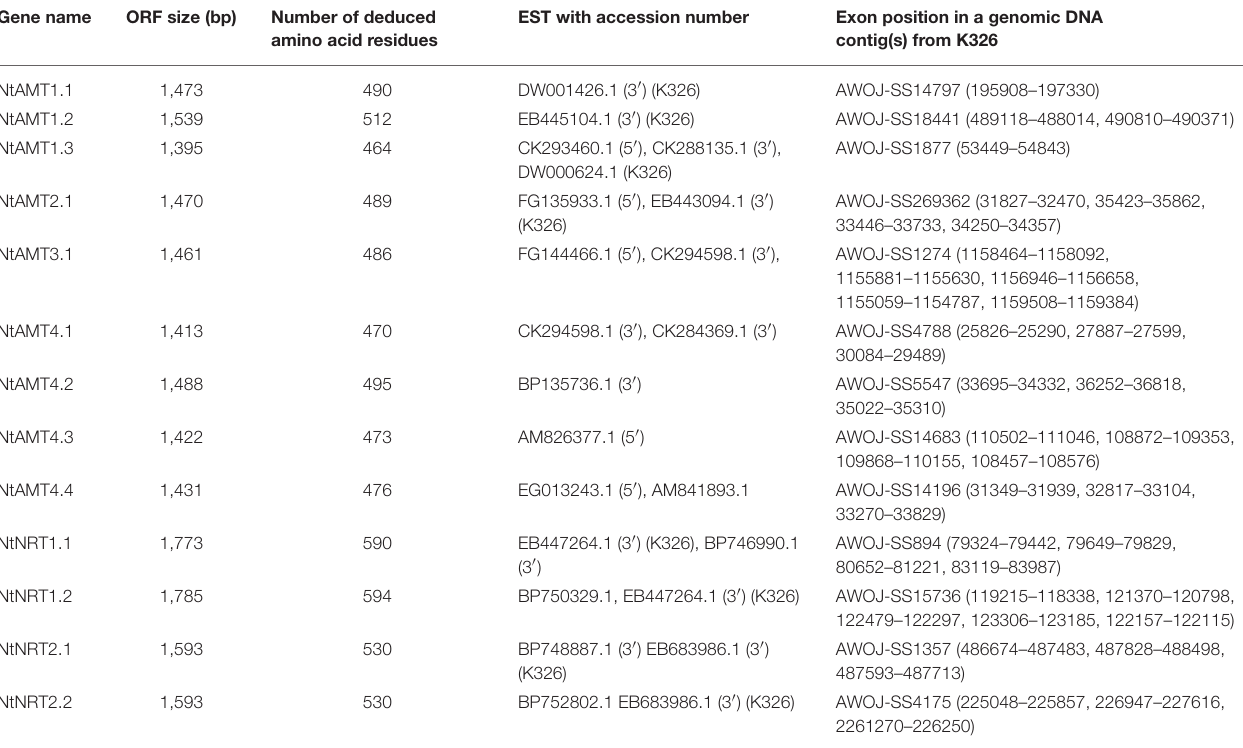
TABLE 1 | Characteristics of AMT and NRT homologous genes in